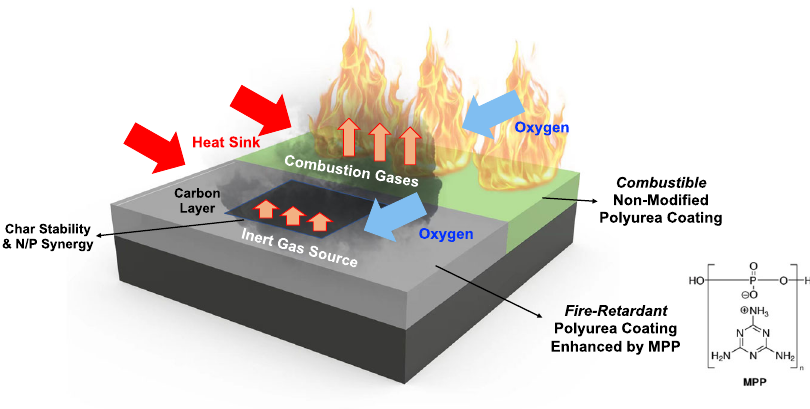
Fig. 8 Fire fl ammability comparison between combustible non-modi fi ed polyurea coating and fi re-retardant polyurea coating enhanced by